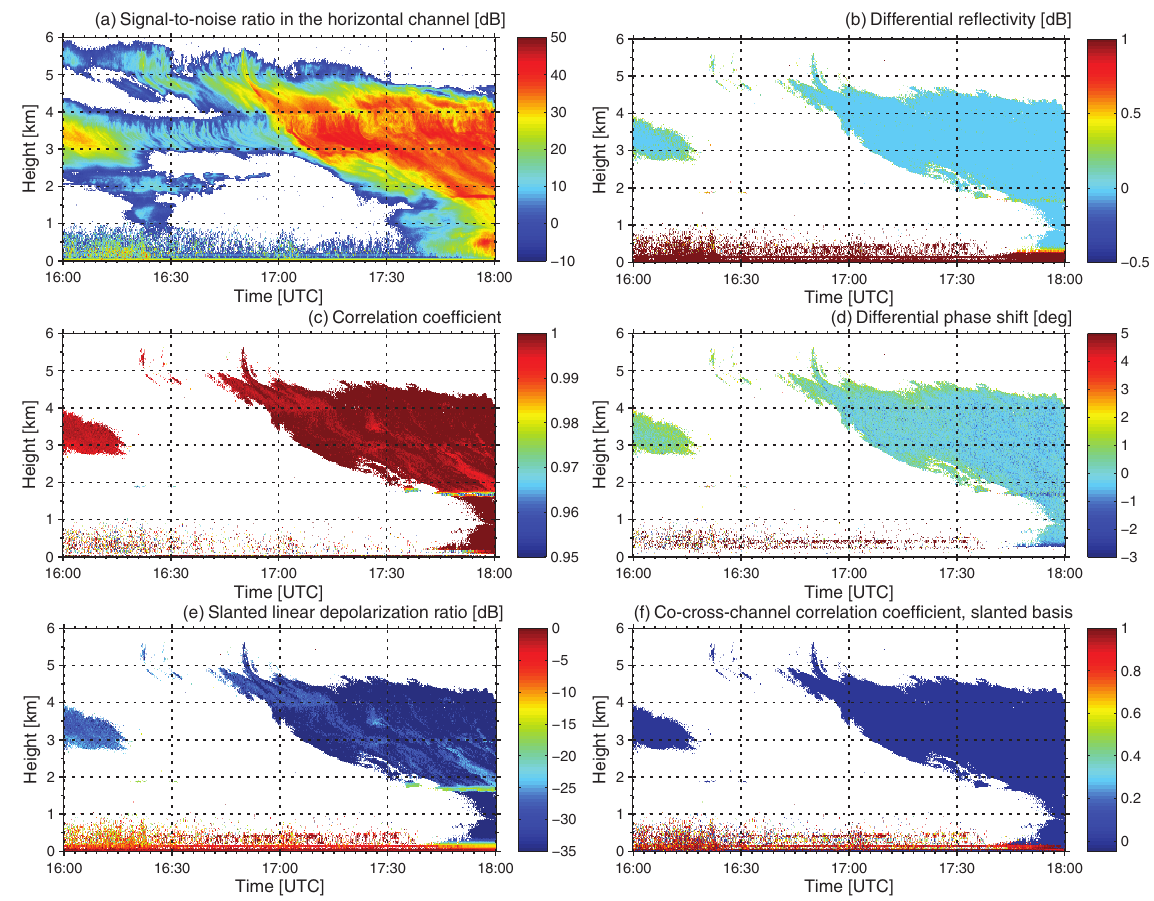
Figure 8. Time–height cross sections of the signal-to-noise ratio in the horizontal channel (a) , differential reflectivity Z DR (b) , correlation coefficient ρ HV (c) , differential phase shift ϕ DP (d) , slanted linear depolarization ratio SLDR (e) , and co-cross-channel correlation coefficient in the slanted basis ρ CX for the measurements taken at Elmshorn, Germany, on 1 May